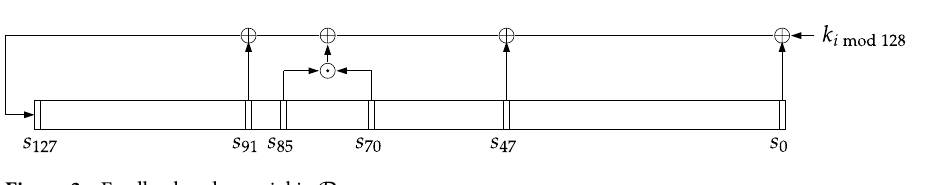
Figure 3. Feedback polynomial in P